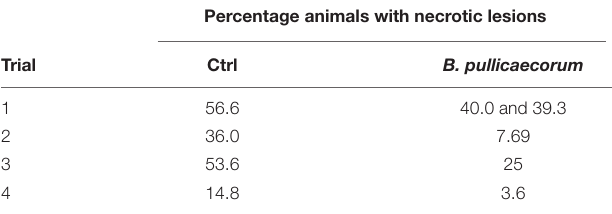
TABLE 3 | Percentage of chickens with macroscopic necrotic enteritis (NE) lesions (lesion score ≥ 2) per trial after challenge with Clostridium perfringens